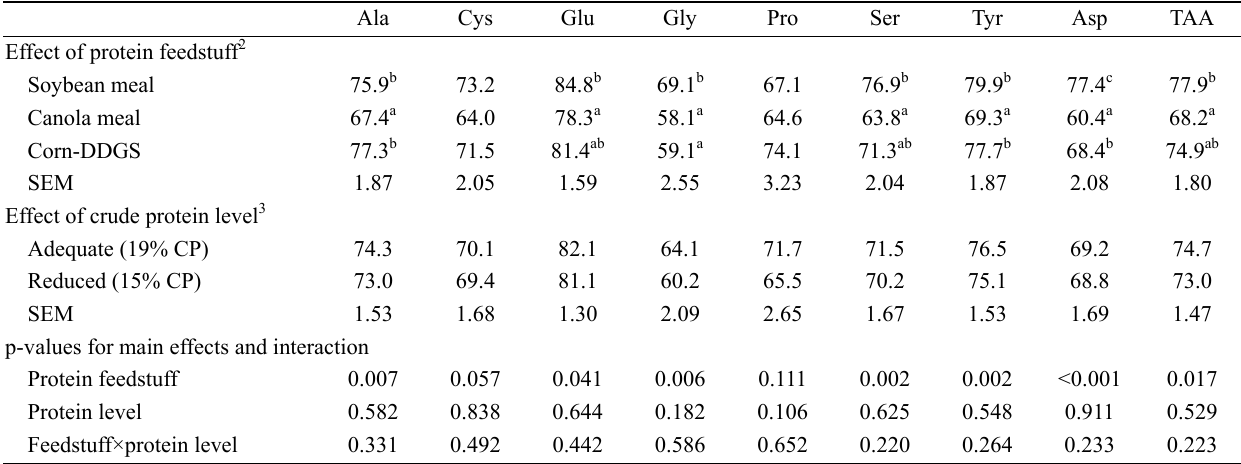
Table 5. Apparent ileal digestibility (%) of total- and dispensable amino acids in growing pigs in response to protein feedstuff used and crude protein level 1